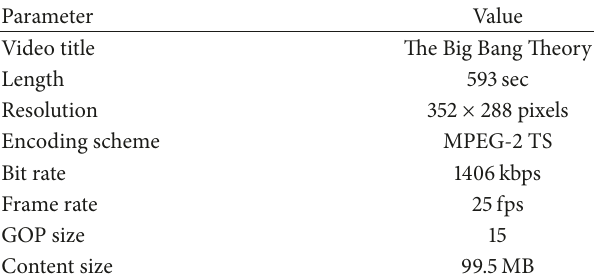
Figure 9: Experimental network scenario 1. Table 2: Information of test video 1.